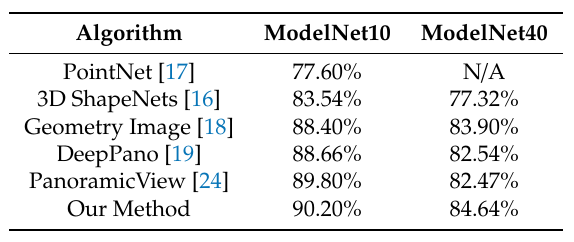
Table 2. The accuracy between the proposed method and other methods on the ModelNet dataset.